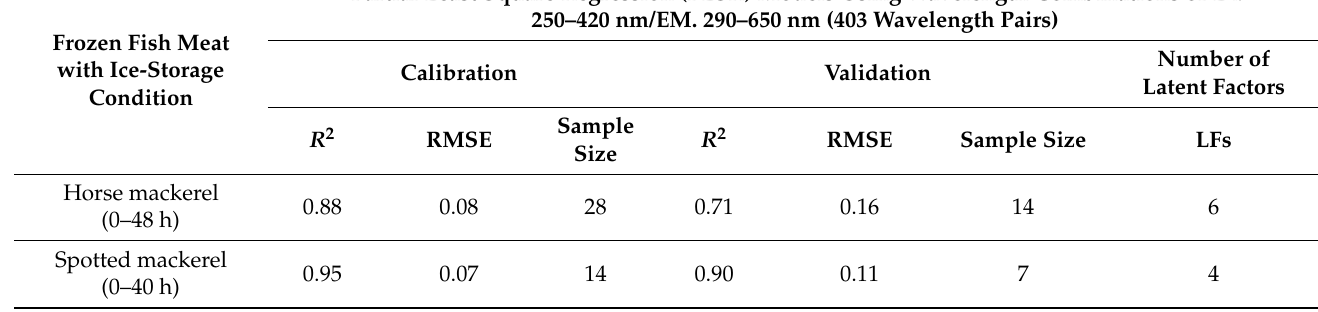
Table 1. Different PLSR models for the prediction of pH changes in frozen fish meat. Partial Least Square Regression (PLSR) Models Using Wavelength Combinations of Frozen Fish Meat with Ice-Storage